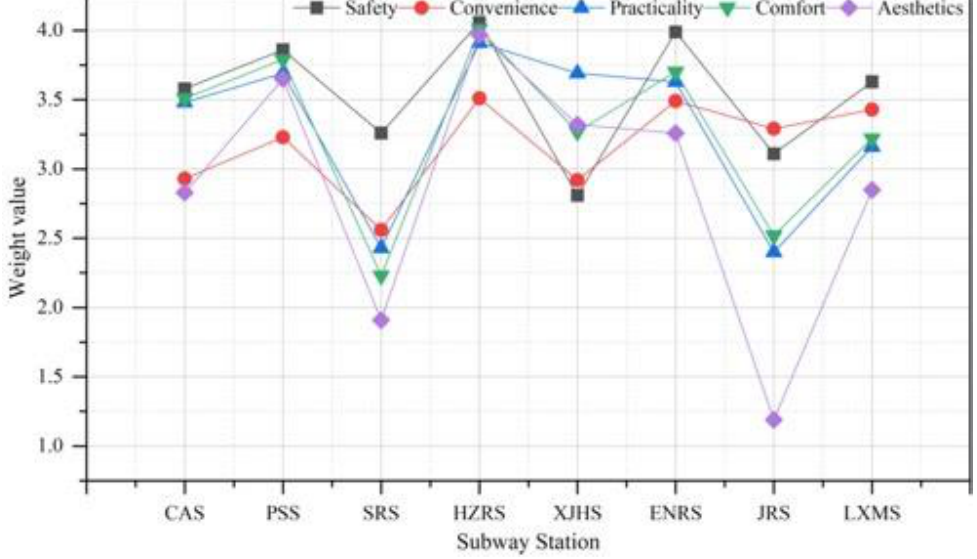
Figure 7. Evaluation index results of the transfer space environment criterion level at sample sta- tions.